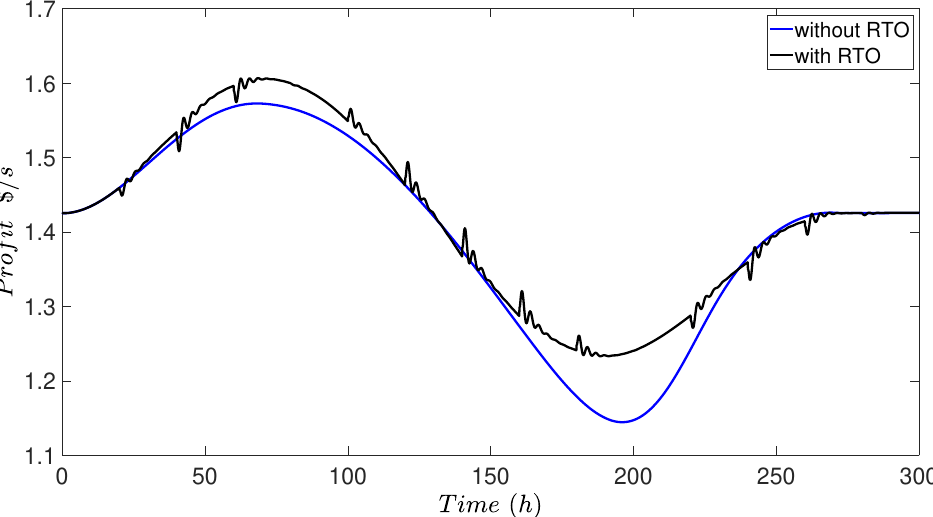
Figure 16. Comparison of the operation profit for the distillation process for closed-loop simulations with and without RTO adapting for change in the feed